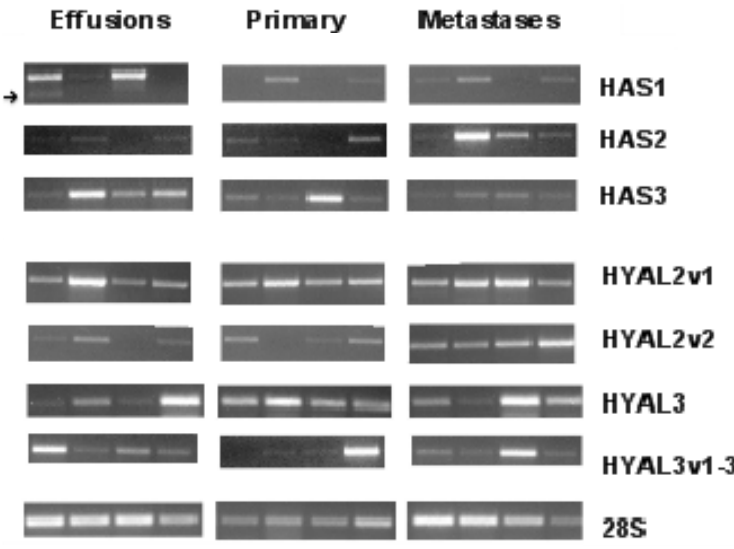
Figure 1. Hyaluronan synthases ( HAS ) and hyaluronidases ( HYAL ) mRNA in